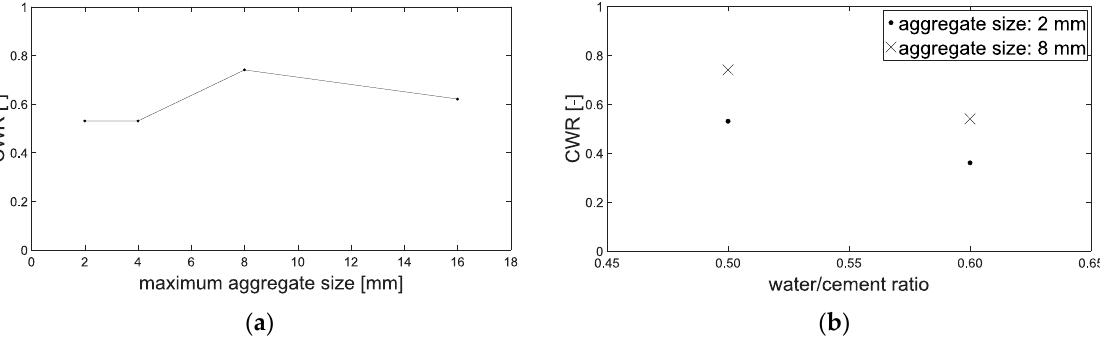
Figure 12. Crack-width ratio CWR: ( a ) Effect of maximum aggregate size, ( b ) Effect of w / c -ratio.